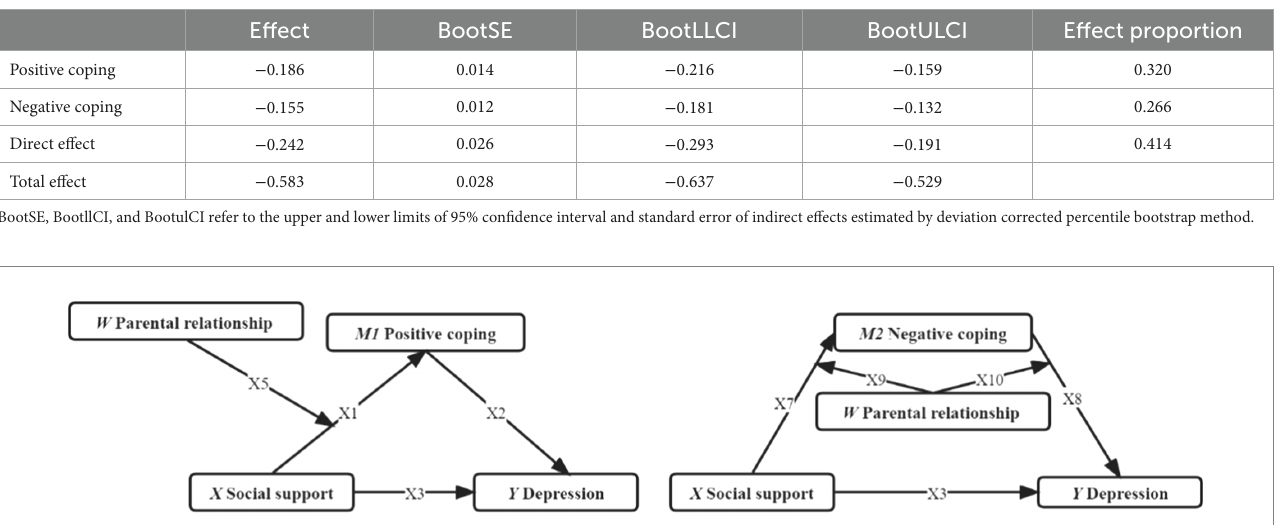
TABLE 4 Tests of the total effect, direct effect, and mediated effect variables.